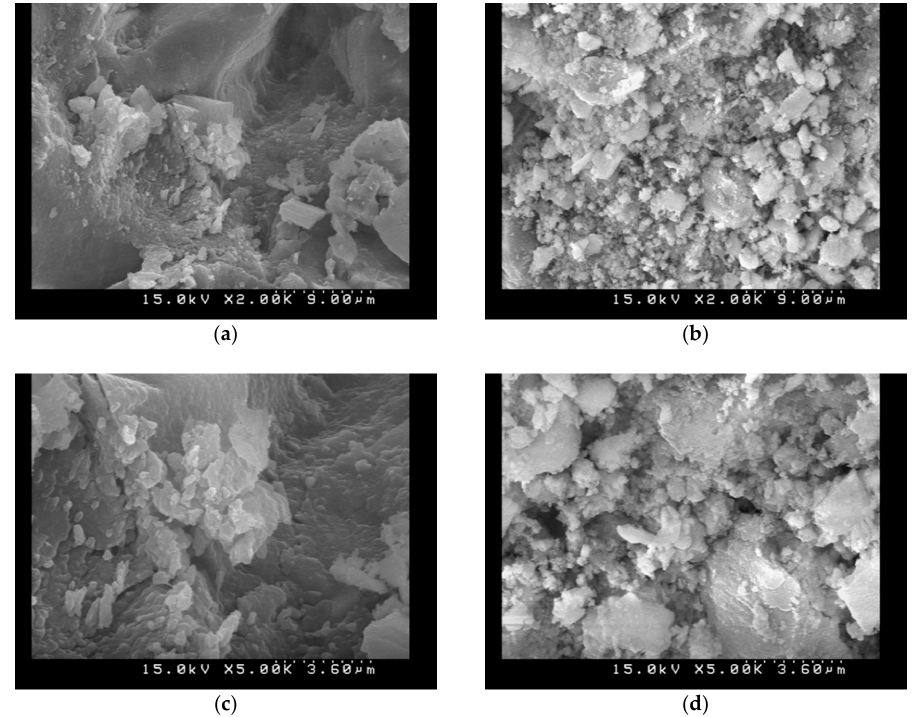
Figure 10. SEM images (S/A = 0.2, L/B = 0.5, P/A = 0.735): ( a ) without carbonation (2000×); ( b ) with carbonation (2000×); ( c ) without carbonation (5000×); and ( d ) with carbonation (5000×).